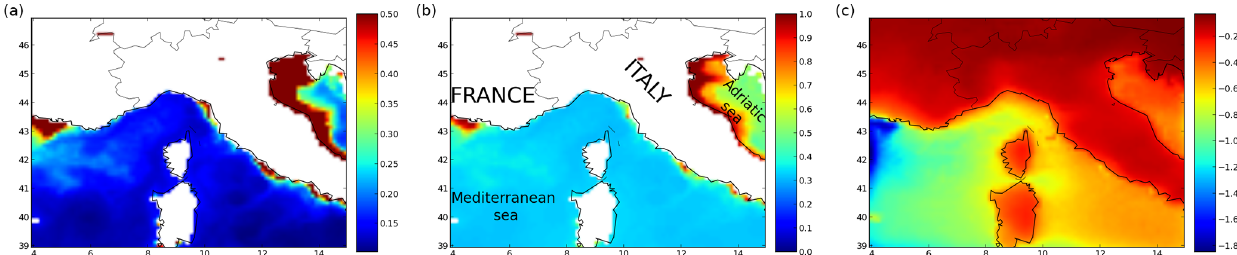
Figure 9. (a) Temporal average of chl a in sea surface in units of mgm − 3 during the summer of 2013 (from 6 June to 3 August). (b) Organic mass fraction of emitted sea-spray aerosols of diameters between 0.01 and 0.1585µm. (c) Relative difference (%) in the concentrations of OM 1 between the base simulation and the simulation including organic sea-salt